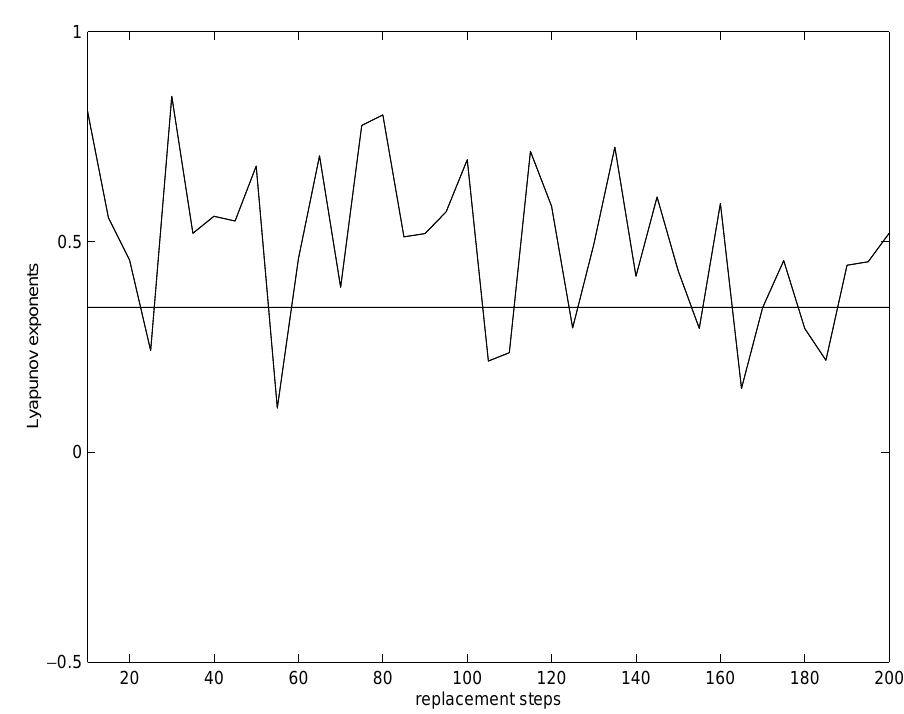
Fig. 14. Evolution of the Lyapunov exponent with respect to replacement